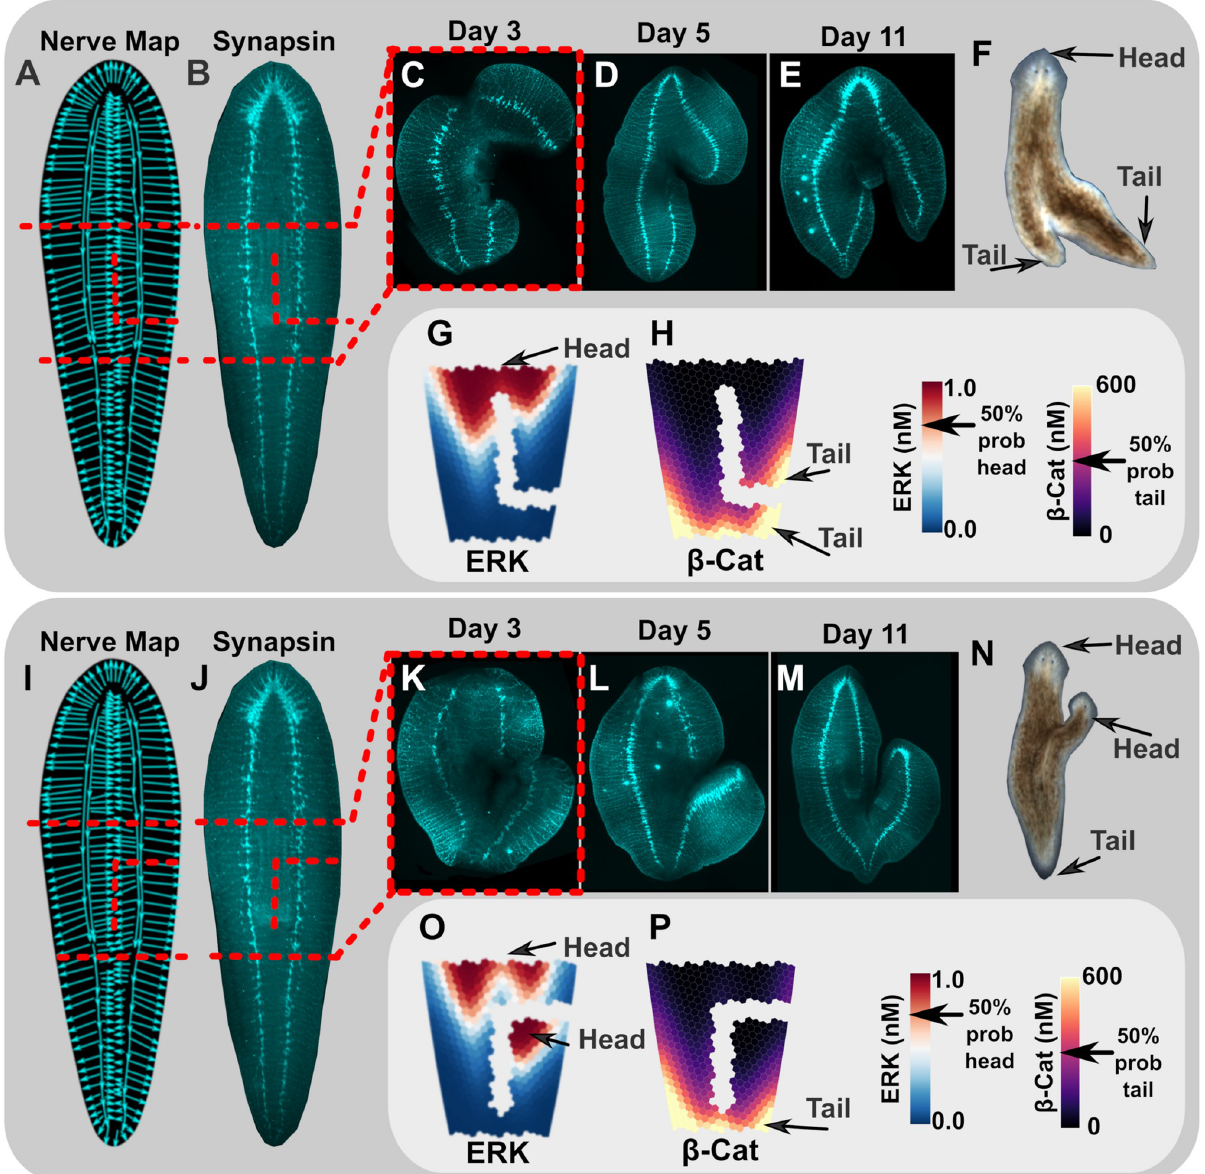
Fig 5. Unique cutting arrangements of 1H worms highlight the key role ventral nerve cords (VNC) play in directing regeneration outcomes. Excised trunk fragments of planaria were cut with an additional incision to generate a long segment containing a VNC with backwards polarity (cuts shown as red dotted line on traced nerve map in A, and on synapsin stain in B), or with an inverted incision of the same pattern to generate a long, free segment containing a VNC with forwards polarity (red dotted line on traced nerve map in I, and on synapsin stain in J). Modeling-predicted morphogen gradients were consistent with the formation of a tail on the long, free segment for the backward-polarity VNC incision pattern (G, H), and head formation on the long, free segment for the forwards-polarity VNC cutting pattern (O, P). These predictions were a direct match to actual regeneration outcomes (N = 80/80). The backwards-polarity VNC (synapsin stains in C, D, E, and final body-plan in F) showed regeneration of a tail on the long, free segment, as predicted. The forwards-polarity VNC (synapsin stains in K, L, M, and final body-plan in N), showed regeneration of a head on the long, free segment, as